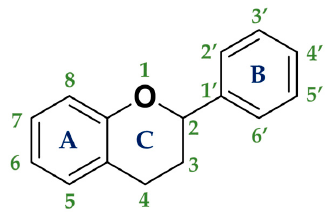
Figure 3. General structure of flavonoids.